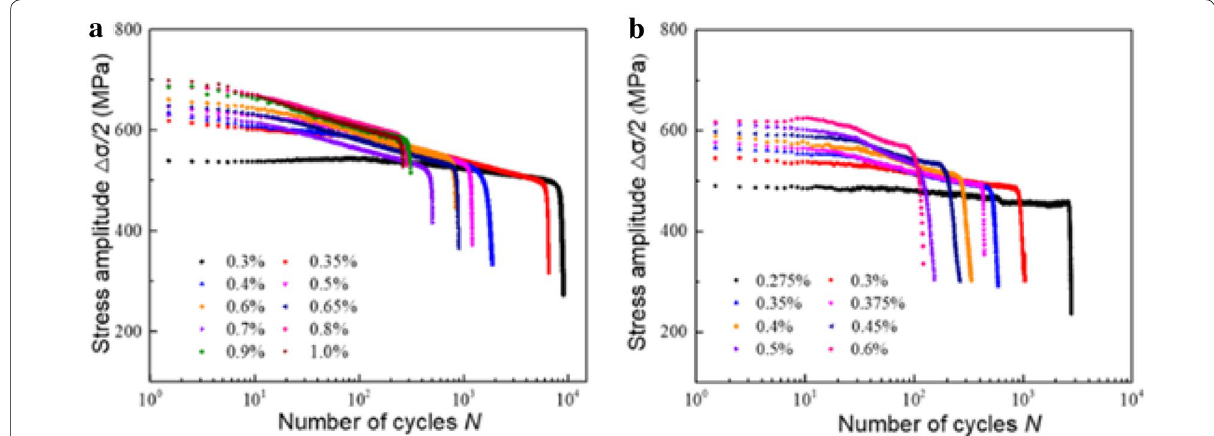
Figure 4 Cyclic deformation behavior at different temperatures: a RT, b 300